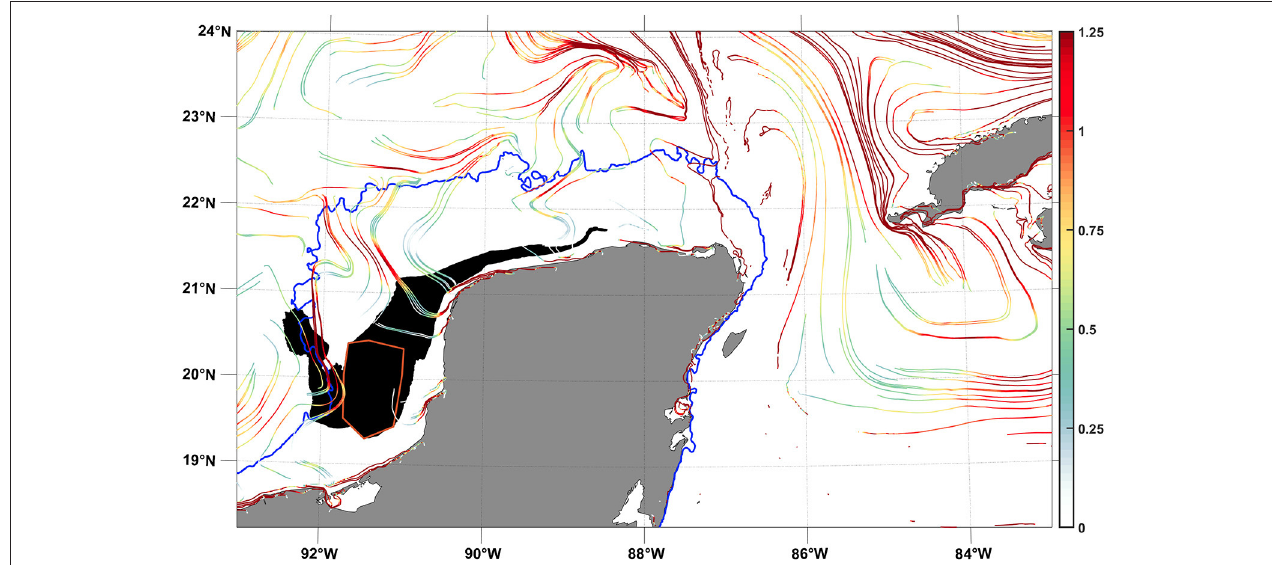
FIGURE 12 | Climatological Lagrangian Coherent Structures (lines) colored according to their climatological strength of attraction (c ρ , logarithmic scale) for July. The trajectories from Figure 10B are plotted in black, with the polygon used for their initial positions is plotted for reference in dark orange. The 50m isobath is shown in blue.